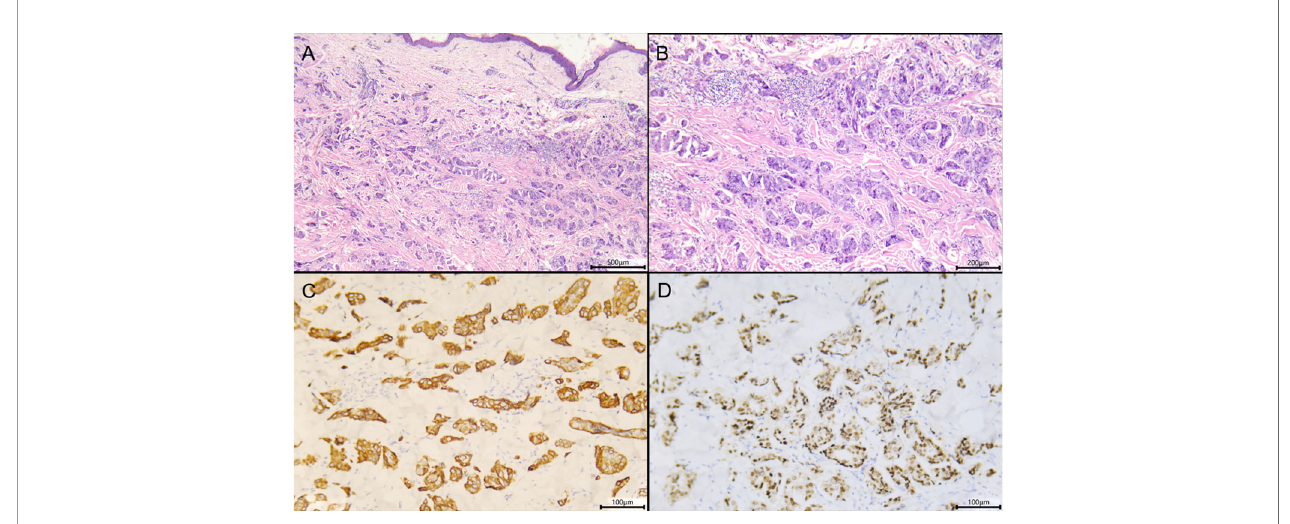
FIGURE 2 | Skin histopathology of the patient. (A, B) Biopsy specimen of the chest showed single fi les or small clusters of monomorphous atypical cells with a cytoplasm rich in vacuoles seen in the dermis [ (A) hematoxylin and eosin, ×50; (B) hematoxylin and eosin, ×100]. (C, D) Immumohistochemical staining showed the tumor cells were CK7+ (C) and ER+ (D) (×200).